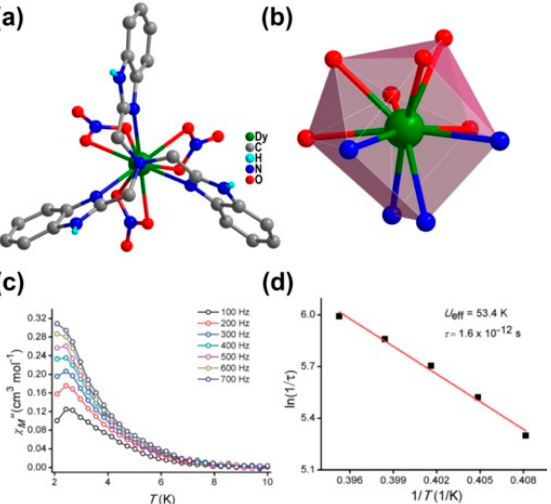
Figure 21. ( a ) Molecular structure of the complex 36 , ( b ) illustration of the “sphenocorona” coordination geometry of the Dy(III) center, and ( c ) out-of-phase ( χ ″ M ) vs. T AC susceptibility plots, ( d ) plot of relaxation time ( τ ) as a function of temperature (T) for 36 at 1200 Oe. Figures and captions are reproduced from Reference [57] with permission from the Wiley-VCH.